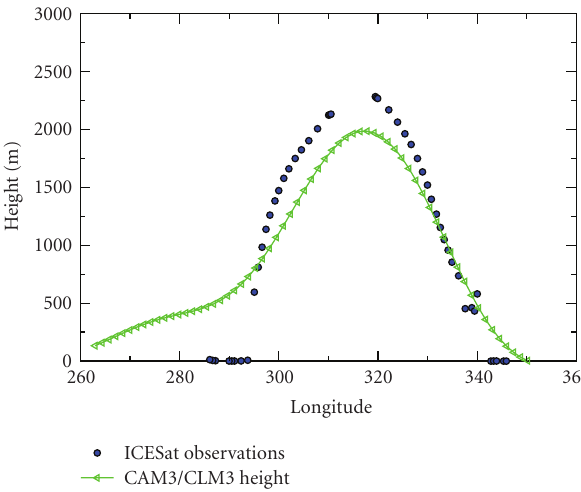
Figure 3: Comparison of surface height from ICEsat measurements with the CAM3/CLM3 surface height along the 80 ◦ N transect across